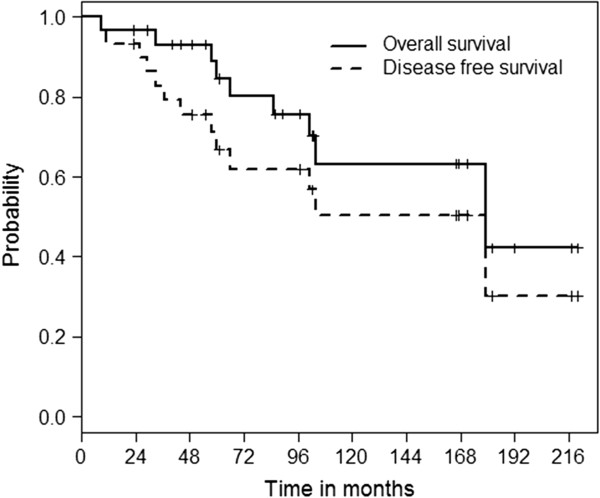
Kaplan-Meier OS and EFS curves of the whole cohort